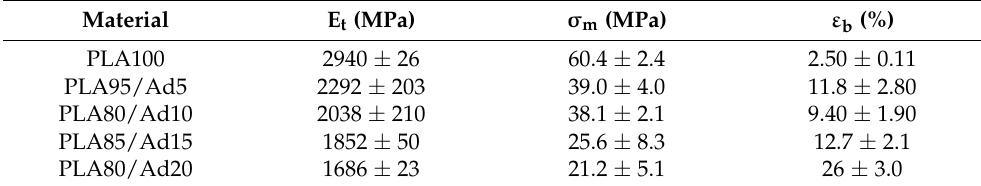
Table 8. Tensile test results of PLA/EVA additive blends.